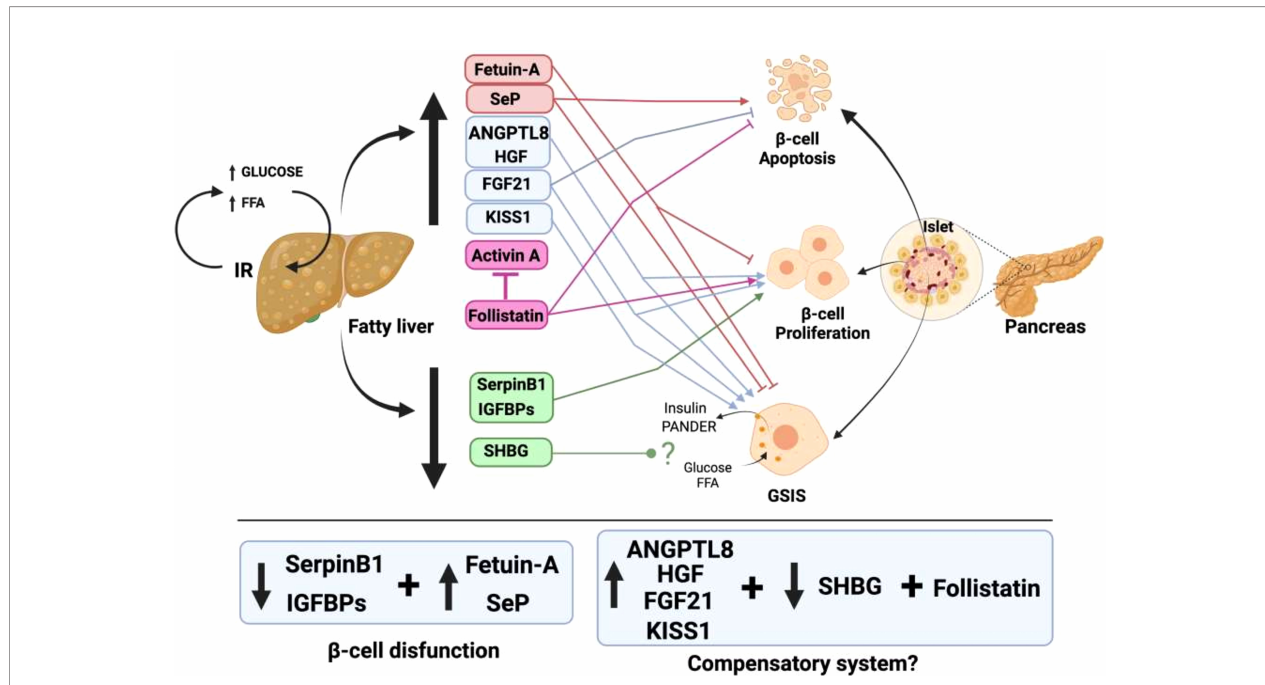
FIGURE 1 | Liver factors involved in the talk of hepatic tissue with pancreatic b -cells in the presence of fatty liver. In conditions of nutrient excess, a fatty liver is produced, together with IR. This fatty liver generates an increased release of hepatokines that have deleterious effects on pancreatic b -cells (red box). In addition, there is an increase in other hepatokines that trigger compensatory mechanisms of increased b -cell proliferation and GSIS enhancement to try to fi ght IR (blue box). In contrast, there is a decrease in the release of other hepatokines that produce an increase in b -cell proliferation to compensate for the dysfunction that exists in them (green